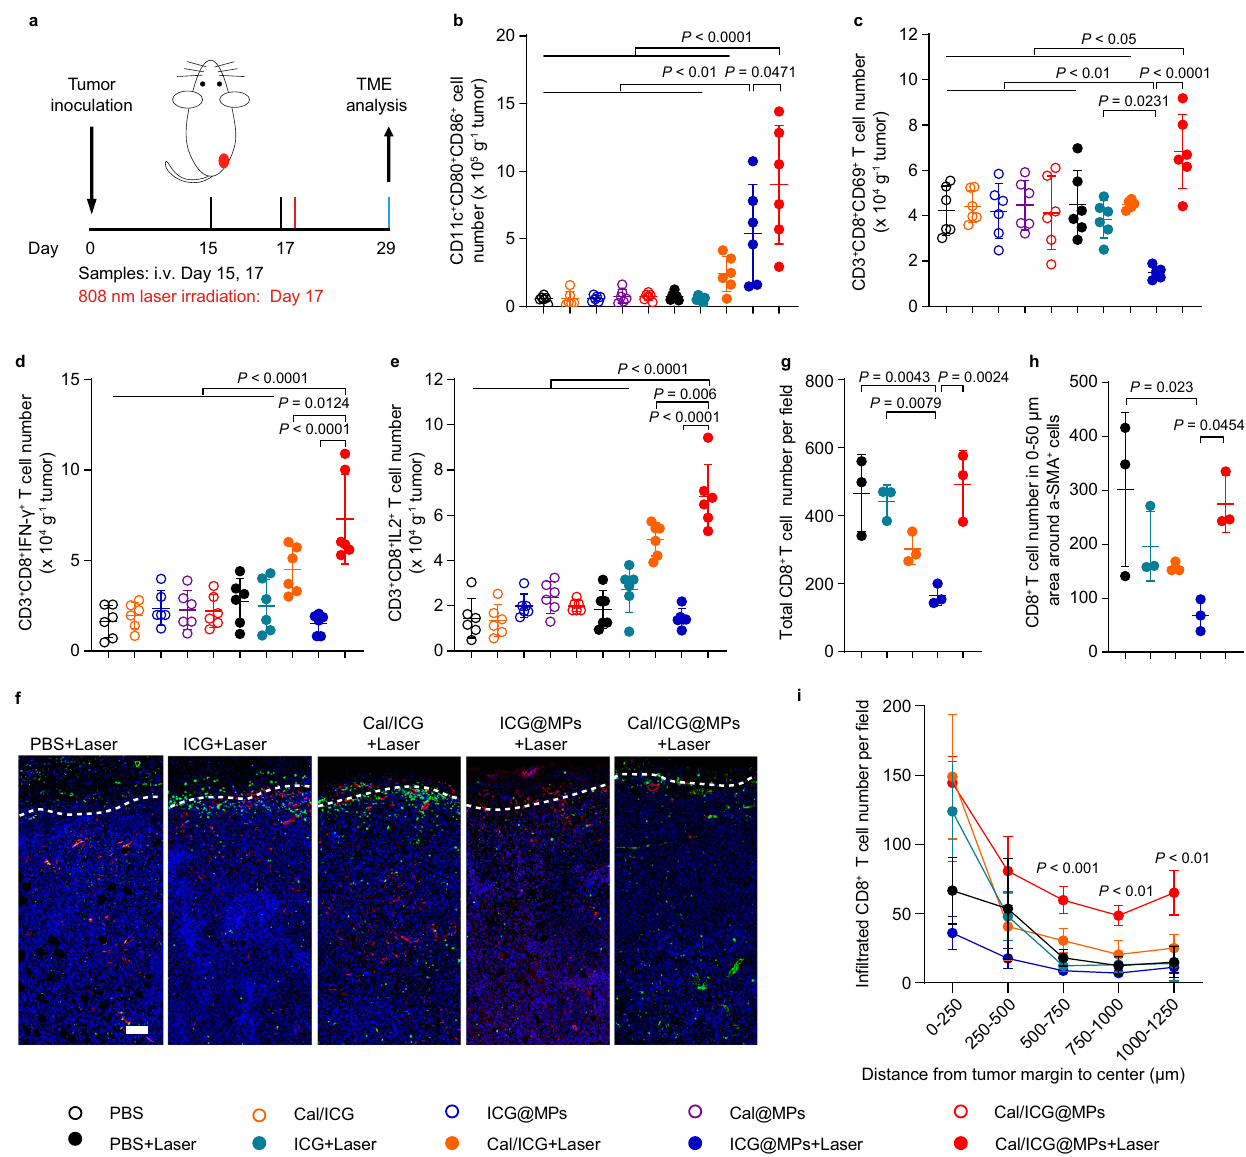
Fig. 6 Cal/ICG@MPs-induced CD8 + T-cell tumor in fi ltration in H22 tumor-bearing mice upon 808 nm laser irradiation. a Schematic schedule for CD8 + T-cell tumor in fi ltration analysis in stroma-rich H22 tumor-bearing mice after intravenous injection of PBS, ICG, Cal/ICG, ICG@MPs, Cal@MPs, or Cal/ ICG@MPs derived from H22 cells at the ICG dosage of 8 mg kg − 1 and Cal dosage of 120 μ g kg − 1 , followed with or without 808 nm laser irradiation (1.5 W cm − 2 , 10 min) at 2 h after the last injection. b – e Numbers of CD11c + CD80 + CD86 + cells ( b ), CD8 + CD69 + T cells ( c ), CD8 + IFN- γ + T cells ( d ), and CD8 + IL-2 + T cells ( e ) in tumor tissues of stroma-rich H22 tumor-bearing mice after treatment indicated in a . Data are presented as means± s.d. ( n =